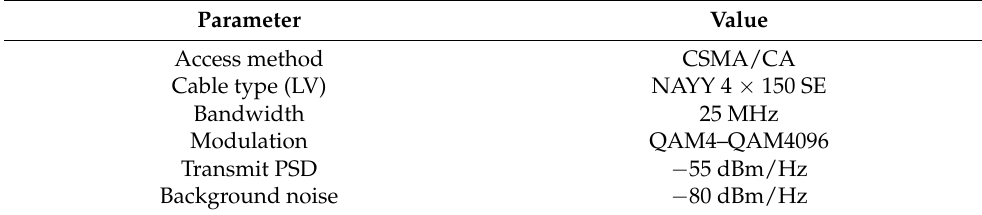
Table 8. Input channel parameters of modulation